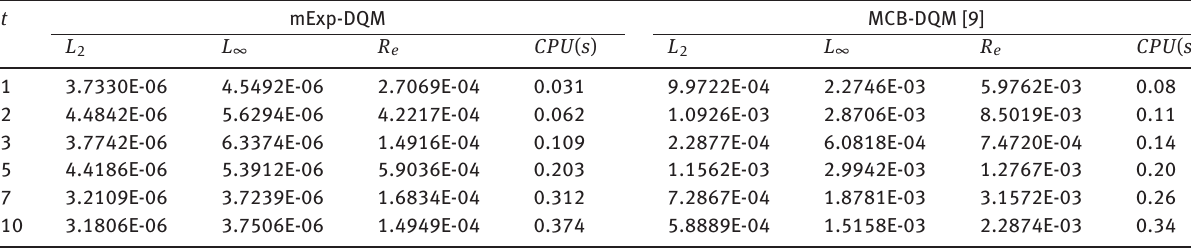
Table 6: Comparison of the mExp-DQM solutions of Example 5.3 with (cid:2) t = 0.01 and h = 0.1, p = 1